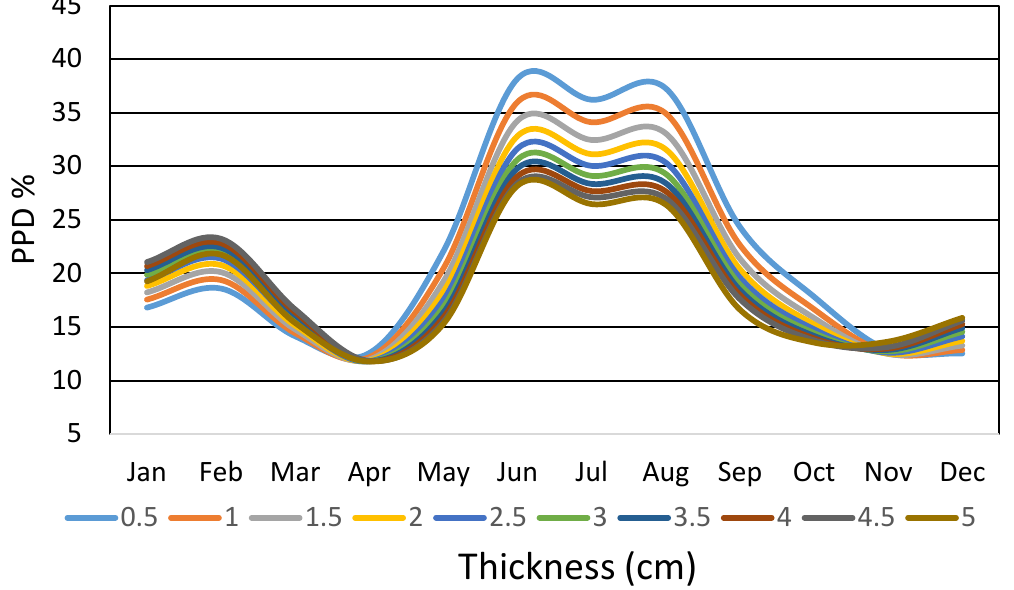
Figure 3. PPD (%) for 10 thicknesses of the PU insulation used on the roof.